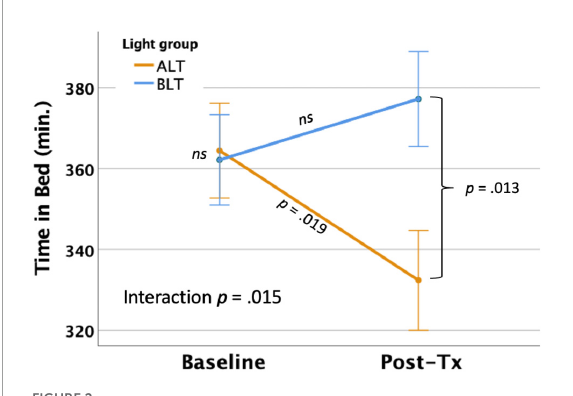
FIGURE2 Six weeks of blue light treatment (BLT) was associated with significantly greater actigraphically measured time in bed (TIB) than an equal period of amber light treatment (ALT), p = 0.015. Orange line = ALT; Blue line = BLT. Error bars = ± 1 SE. Post hoc comparisons are Bonferroni corrected.